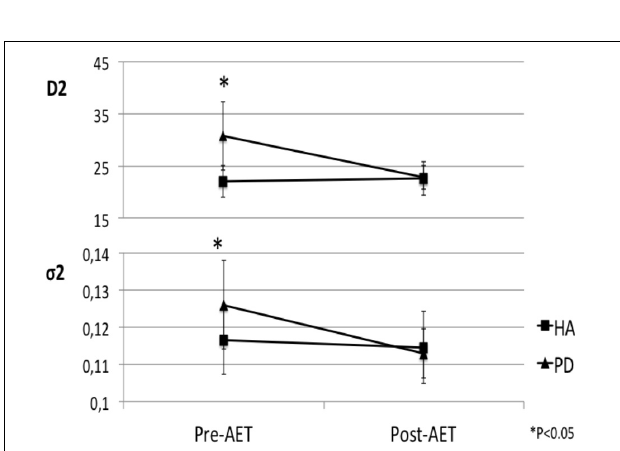
FIGURE 2 | Agonist and antagonist responses before and after AET for PD and HA groups. AET, aerobic exercise training; PD, Parkinson’s disease patients; HA, healthy adults.